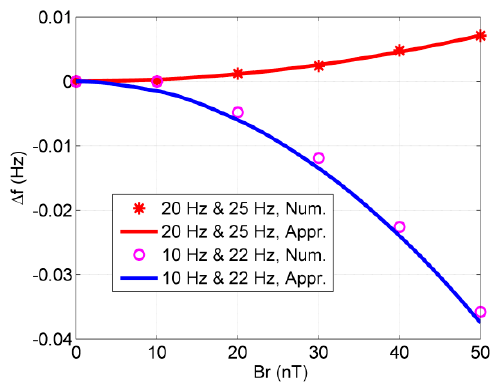
Figure 6. The frequency shift vs. magnetic field amplitude for different groups of magnetic fields. Two groups of magnetic field are given: one is f r 1 = 20 Hz and f r 2 = 25 Hz while another is 10 Hz and f r 2 = 22